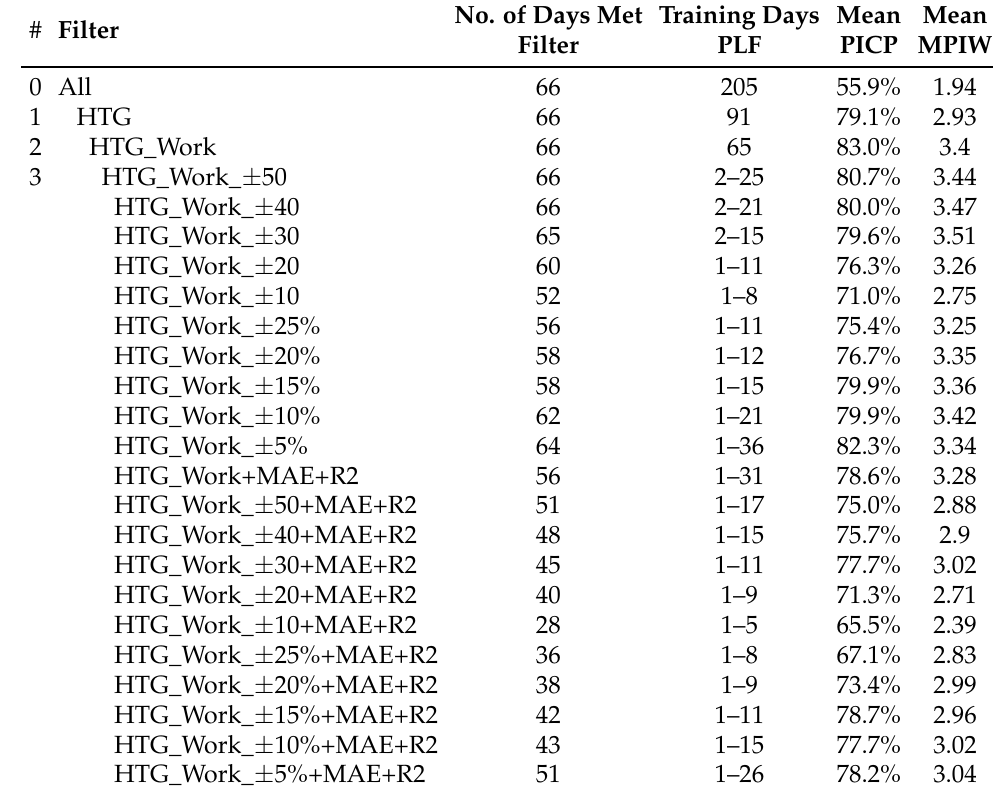
Table 2. PLF calculation results for heating weekdays.